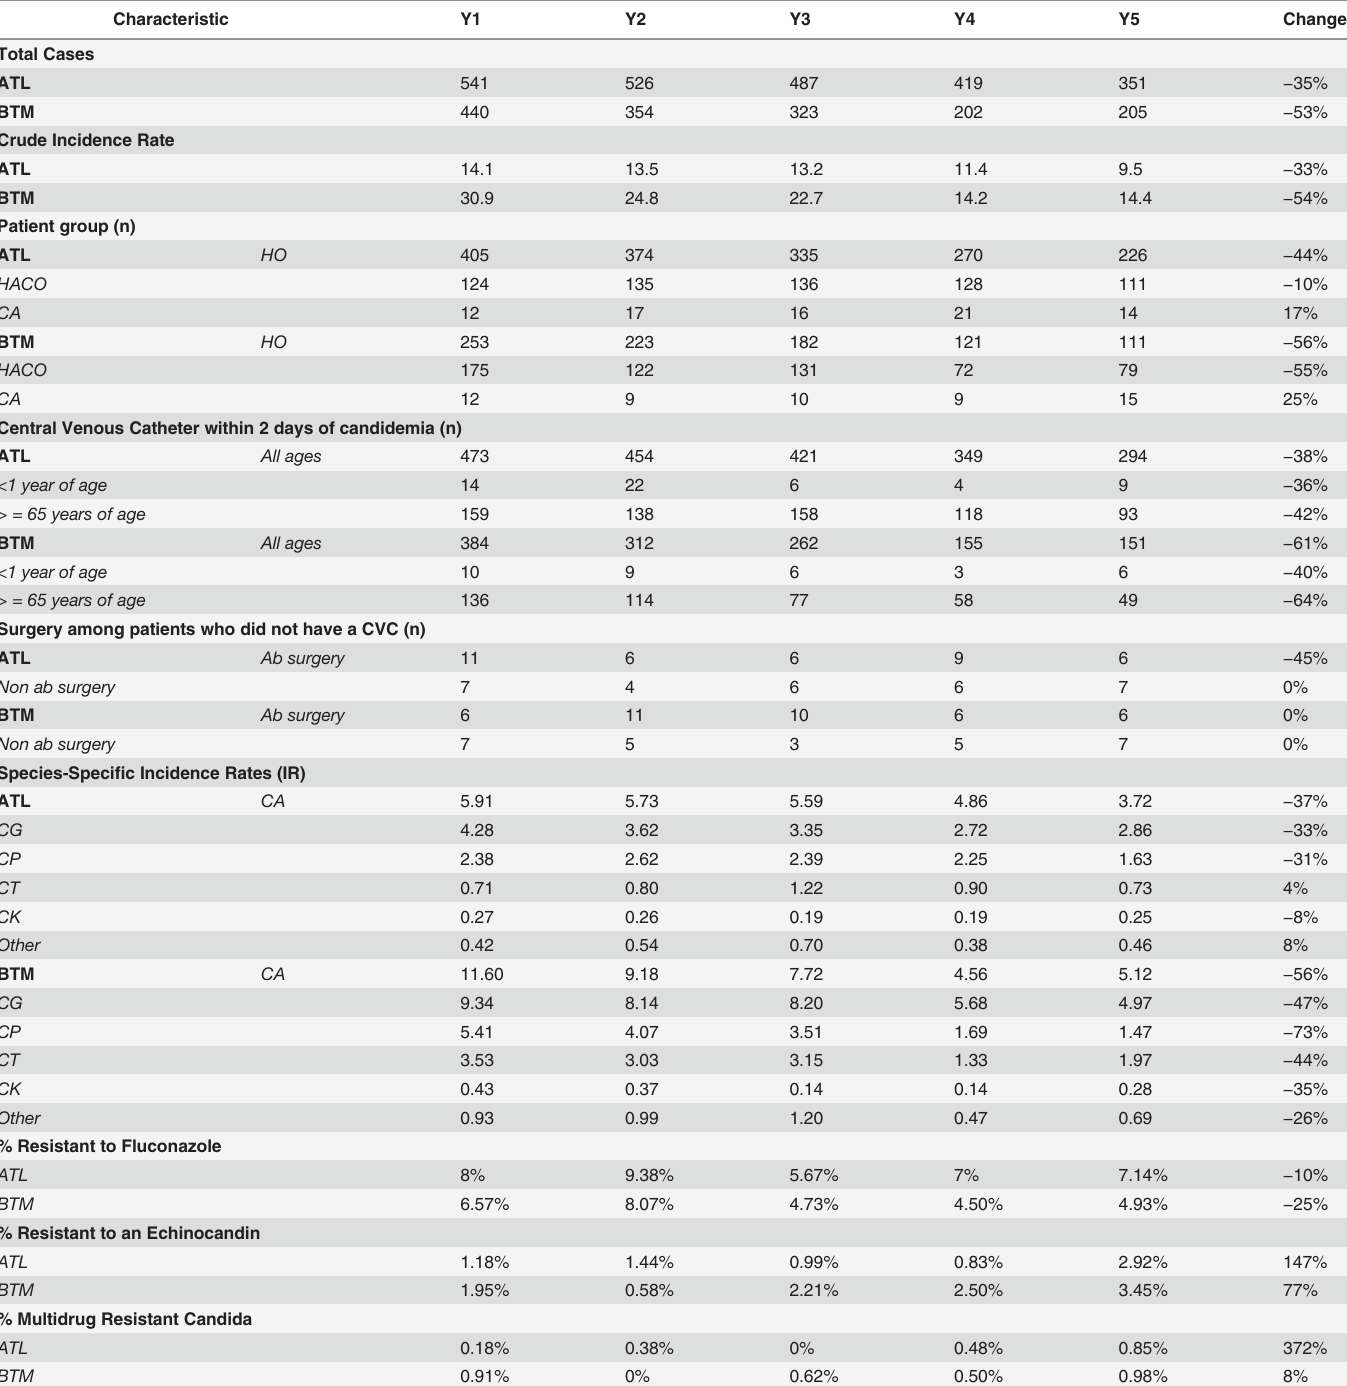
Table 2. Selected characteristics of candidemia patients by year of surveillance, in Atlanta (ATL) and Baltimore (BTM) metropolitan areas. Characteristic